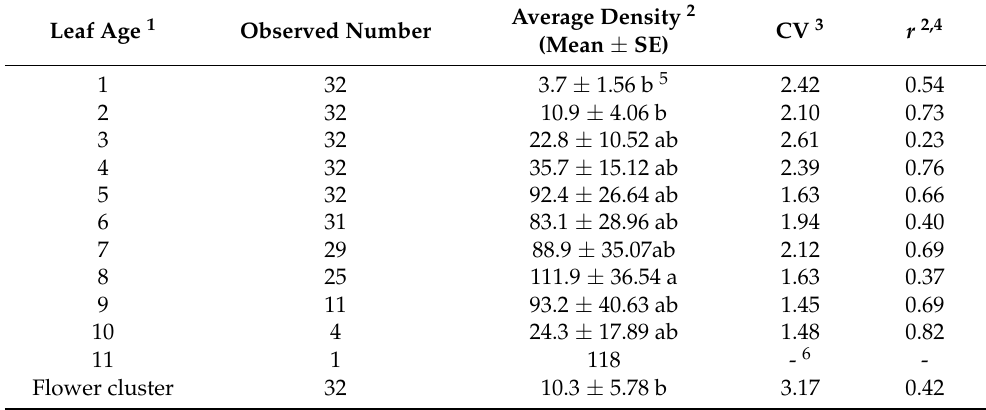
Table 2. Observed plant number, average density, coefficient of variation (CV), and coefficient of determination ( r 2 ) of T. urticae motiles according to leaf age within a strawberry plant in the first farm. Leaf Age